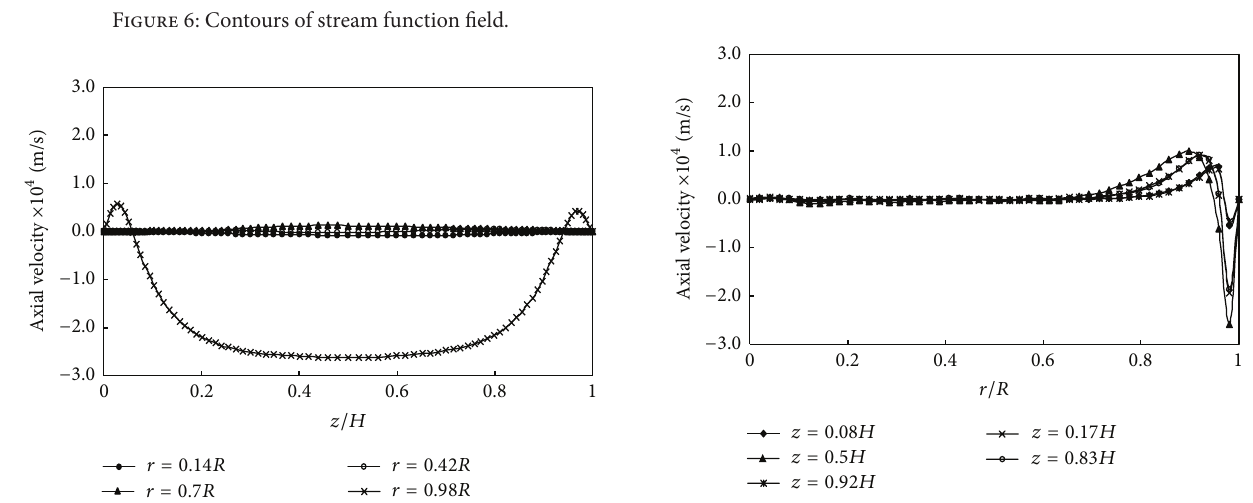
Figure 9: Profile of axial velocity along radial direction.